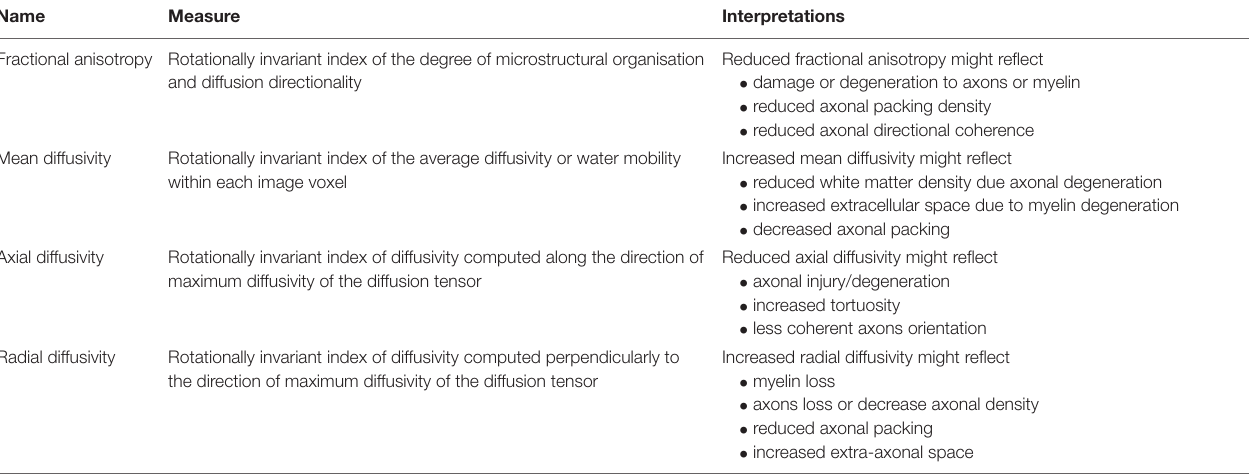
TABLE 1 | Main characteristics and interpretations of diffusion magnetic resonance imaging (MRI) metrics.